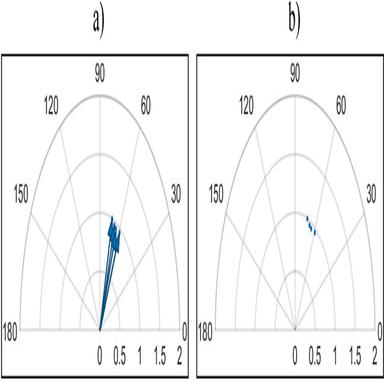
Example of a phasor diagram assembled from s-SNOM amplitude and phase data; (a) the classical way of representing vector using arrows; (b) the way of representing vectors by using a dot in the location of the arrow's tip.